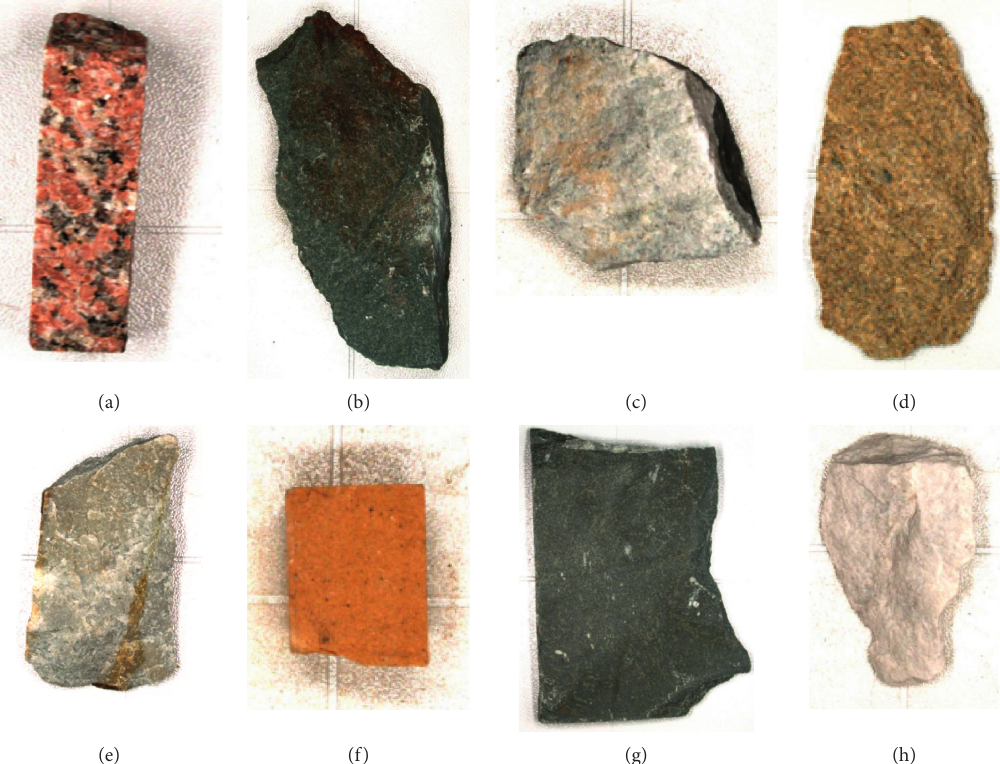
Figure 3: Images of different types of rocks. (a) Granite sample. (b) Diabase sample. (c) Anorthosite sample. (d) Quartz sandstone sample. (e) Limestone sample. (f) Sandstone sample. (g) Shale sample. (h) Quartzite sample.